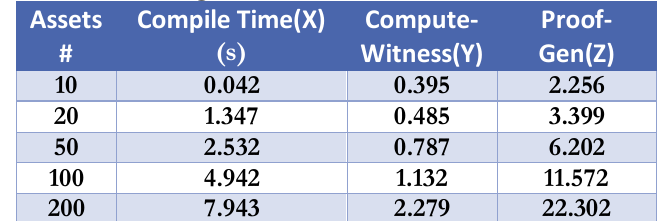
Table 4: Profiling Results for Prover